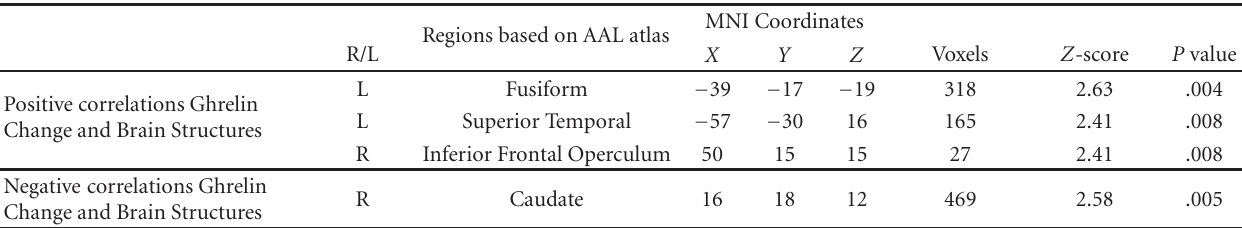
Table 3: Correlations between grey matter volumes and fasting ghrelin levels changes observed in schizophrenia patients after olanzapine treatment.